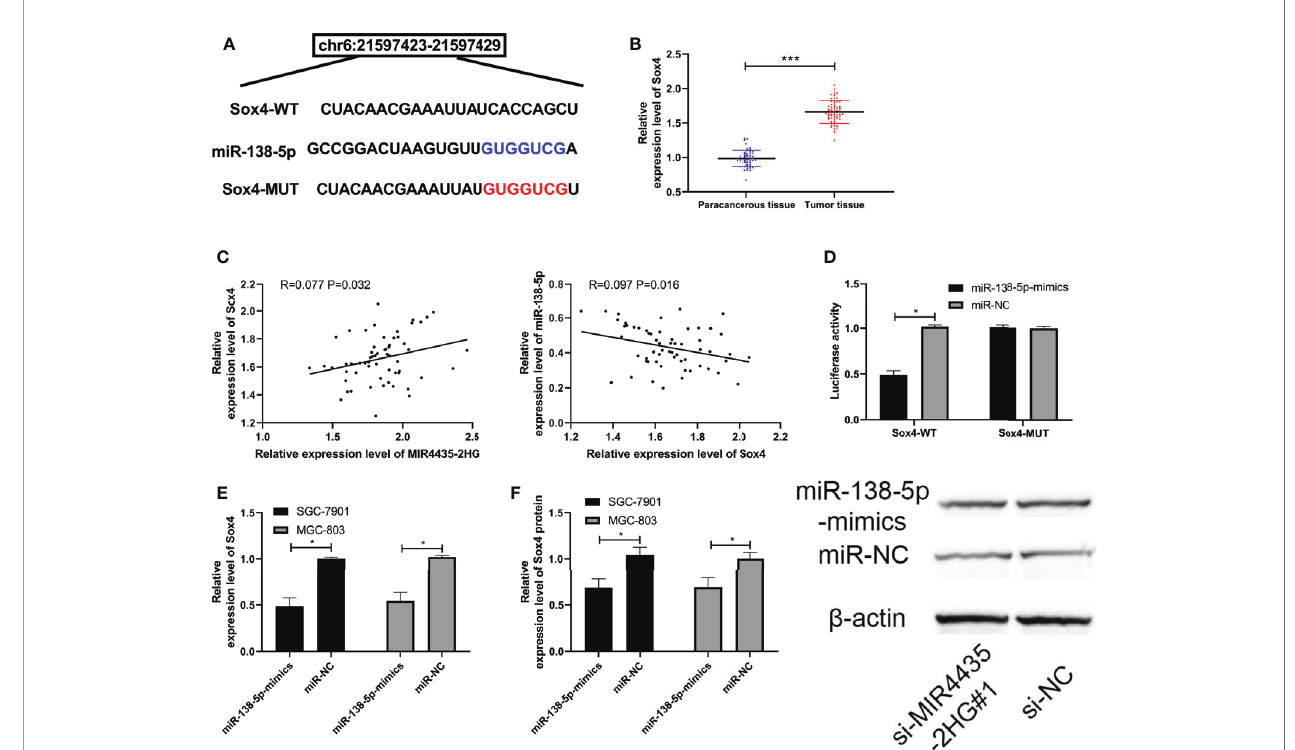
FIGURE 4 | miR-138-5p targeted Sox4. (A) Speci fi c binding sites of miR-138-5p and Sox4. (B) qRT-PCR was applied to test Sox4 in gastric carcinoma patients. (C) Pearson ’ s test was applied to test the correlation of Sox4 with MIR4435-2HG and miR-138-5p. (D) Double luciferase report con fi rmed that MIR4435-2HG combined with miR-138-5p in SGC-7901 and MGC-803 cells. (E, F) qRT-PCR and Western blotting (WB) were applied to test miR-138-5p in gastric carcinoma cells transfected with si-MIR4435-2HG#1 in SGC-7901 and MGC-803 cells. * indicates p < 0.05; *** indicates p <